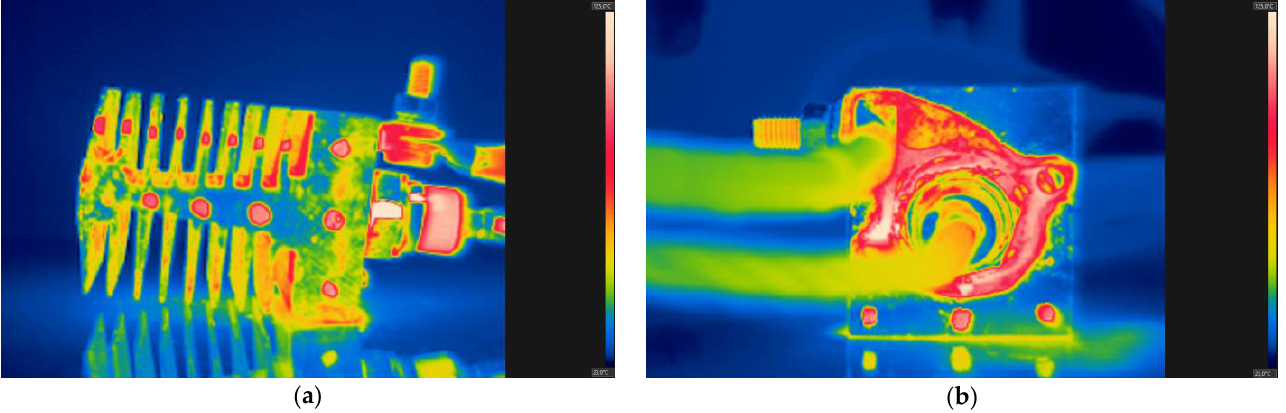
Figure 8. The thermograms showing a heat sink for a power of P j = 117.99 W: ( a ) side view; ( b ) top view. The temperature on the thermogram ranges from 23 °C to 125 °C.